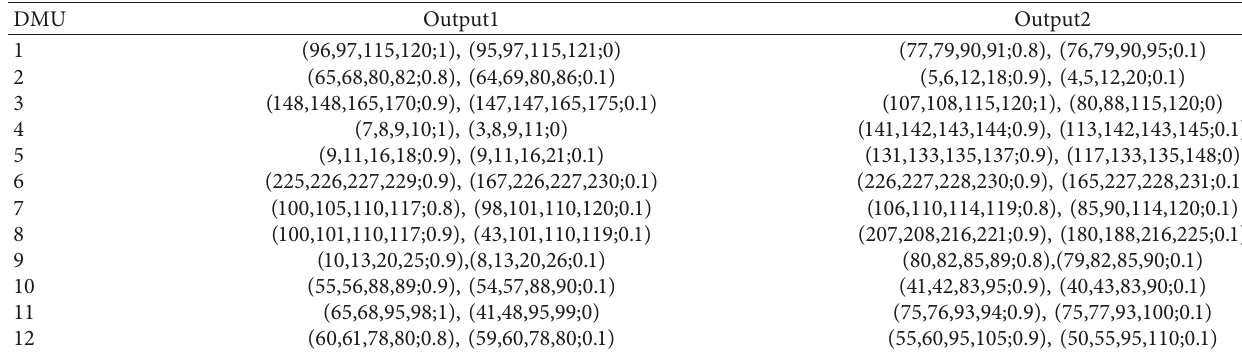
Table 3: Trapezoidal intuitionistic fuzzy outputs of the second stage of the 12 DMUs.